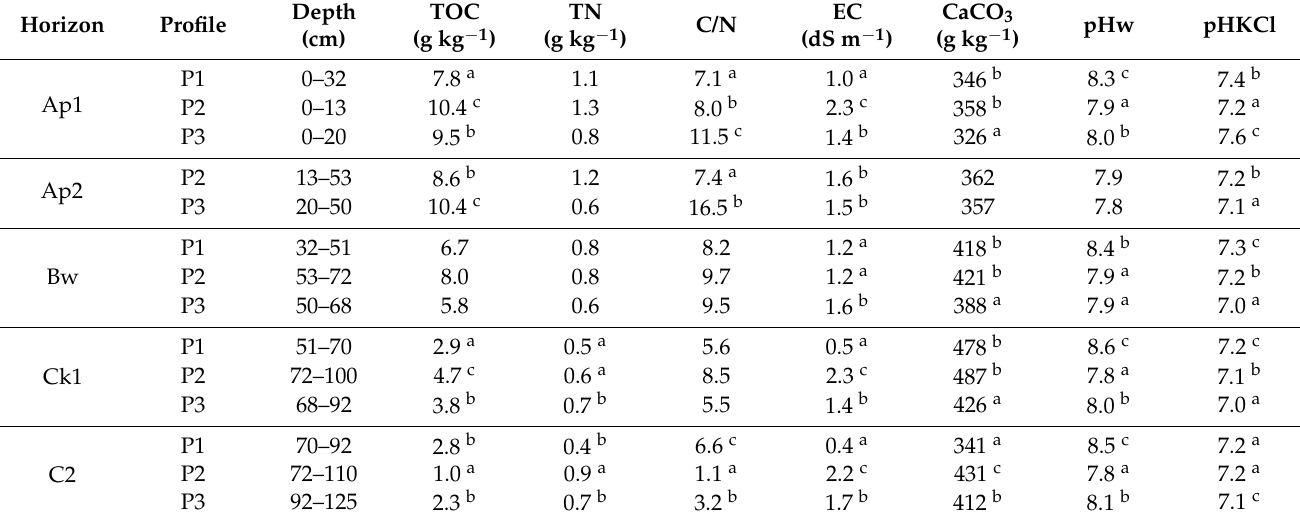
Table 1. Total organic carbon (TOC), total nitrogen (TN), C/N ratio, electrical conductivity (EC), CaCO 3 content, and pH (water and KCl).